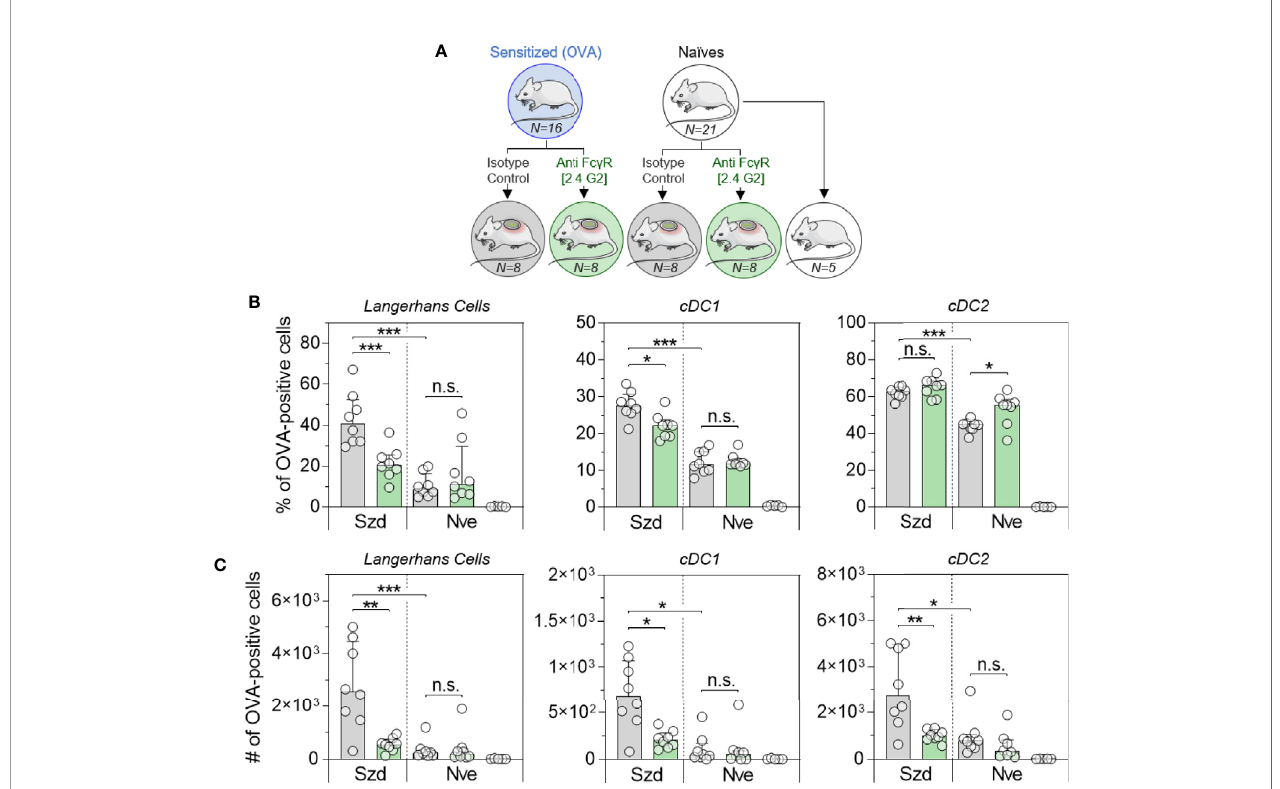
FIGURE 5 | Allergen uptake by skin DC is enhanced in sensitized animals and involves Fc receptors. (A) OVA-sensitized (Szd) or naïve (Nve) mice received anti- Fc g RII/RIII antibodies (in green) or relevant isotype control (in grey). Twenty-four hours after blocking antibody injection, mice received a patch containing OVA-AF488 on depilated areas of the back (in blue). As a negative control a group of naive mice was kept untreated (in white). (B) Six hours after patch application, a skin sample corresponding to the patch application area was collected and cells were analyzed by Flow Cytometry. The percentage of OVA positive cells was measured among Langerhans cells, cDC1 and cDC2, as indicated. (C) Forty-eight hours after patch application, brachial draining lymph nodes were collected, and cells were analyzed by Flow Cytometry. The number of OVA positive cells was measured among migratory Langerhans cells, cDC1 and cDC2, as indicated. Data are Median and interquartile ranges of individual values (N = 8 per group, single experiment). P values were determined according to the Mann-Whitney test (*P < 0.05; **P < 0.01; ***P < 0.001; n.s., non-signi fi